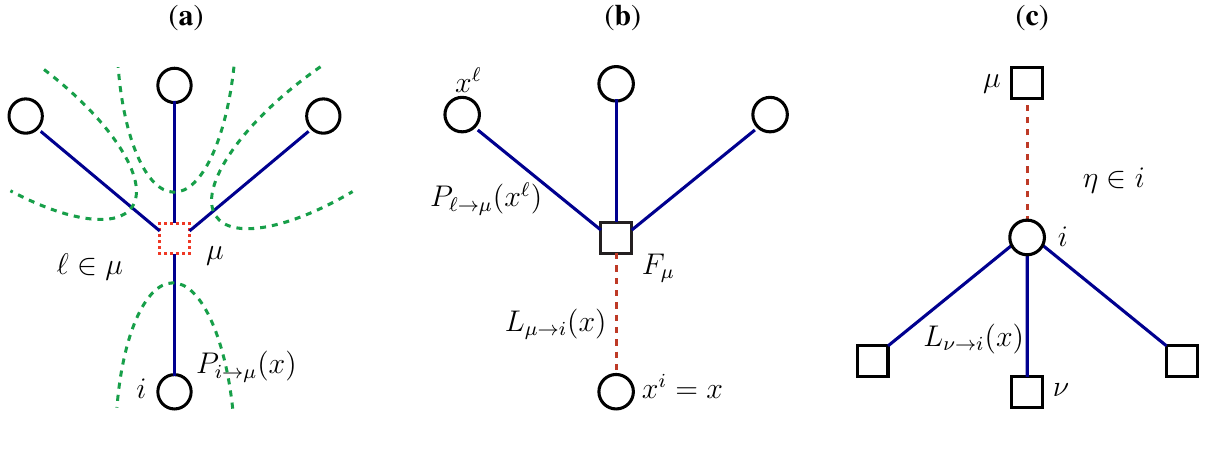
Figure 1. The method used to derive self-consistency Equations (9) and (10) for the conditional marginals; we only show the nearest neighbours of what one must imagine to be a large tree-like bipartite graph, where circles are reactions and squares, metabolites. ( a ) Metabolite µ and the reactions that process it ( (cid:96) ∈ µ ). If we assume removing µ from the system, all reactions connected to it belong to disjoint branches of the metabolic network, highlighted with the dashed lines. As a consequence, their joint probability distribution ( x ) , of each reaction (cid:96) . function (PDF) factorizes in the product of the marginals, P (cid:96) → µ ( x ) , of satisfying its ( b ) When metabolite µ is put back in the graph, the probability, L µ → i mass balance condition when fixing the flux of reaction i to x depends on the marginals, P ( x ) , of all neighbours, but i , and on the indicator function, F . ( c ) The marginal (cid:96) → µ µ P ( x ) , which is computed in absence of µ , expresses the probability that i satisfies the i → µ mass balance conditions for all the metabolites it processes ( η ∈ i ), except µ . On a tree, each mass balance condition is independent, so that the probability of satisfying all of them ( x ) is given by the product of the various L ν → i